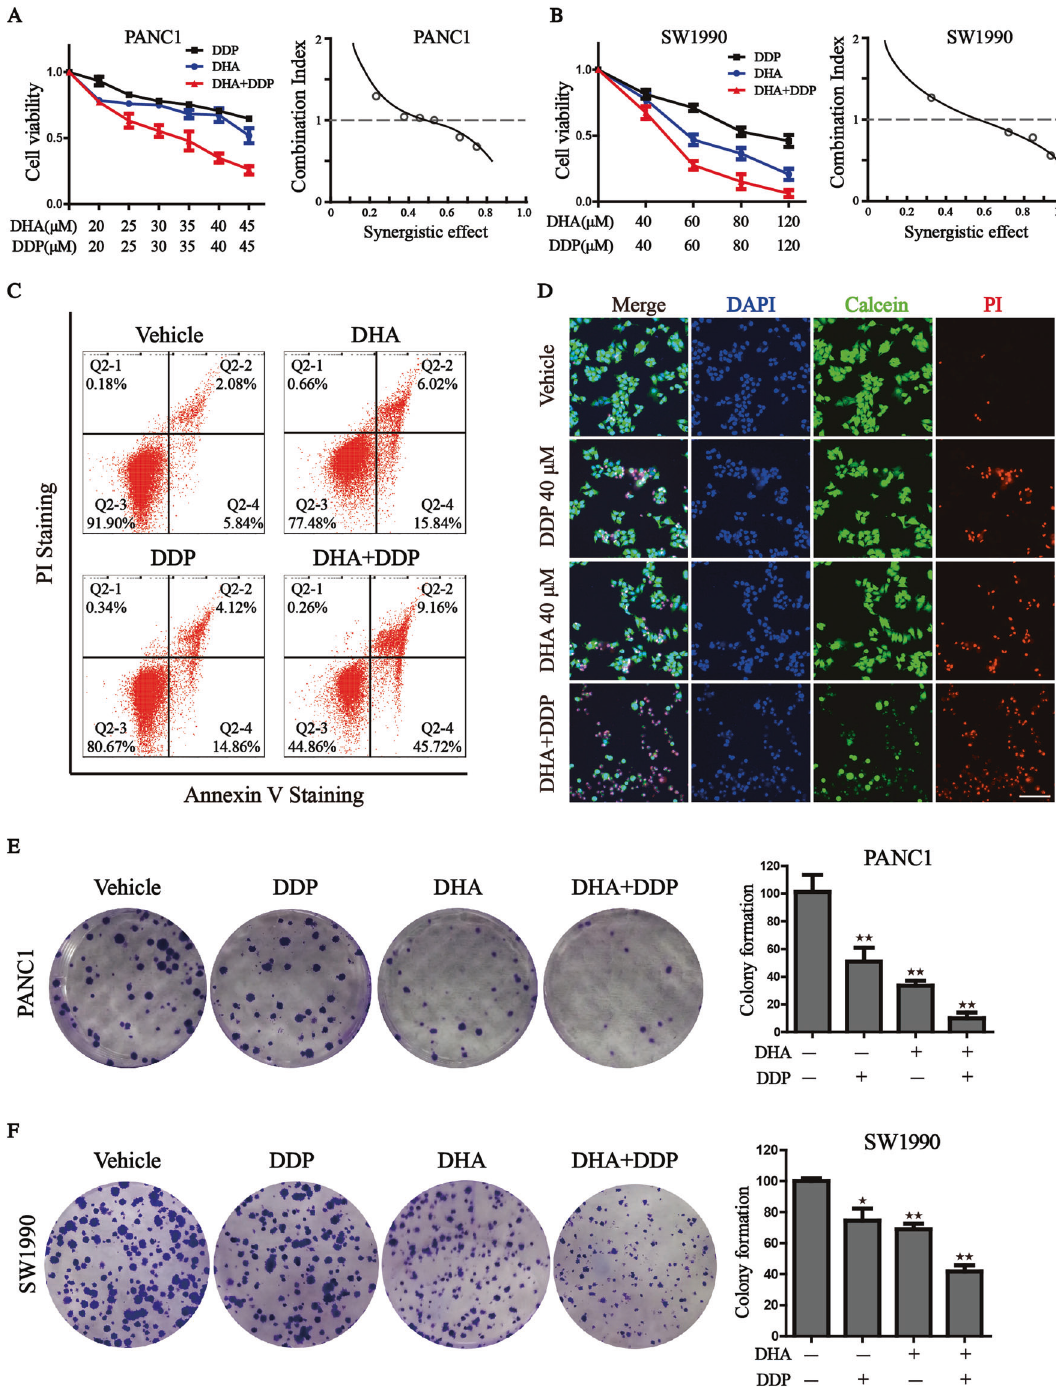
Fig. 1 Synergistic antitumor effect of DHA in combination with DDP. A , B Pancreatic cancer cells were subjected to different concentrations of DHA and DDP treatment for 24 h and cell viability was detected by CCK-8 assay. Combination index (CI) values were calculated by Compusyn software. C PANC1 cells were subjected to 40 µM DHA or/and DDP treatment for 24 h and followed by Annexin V-FITC/PI assay. D PANC1 cells were pretreated with 40 µM DHA or/and DDP for 24 h and subjected to the Calcein-AM/PI staining (Calcein AM: live cells, PI: dead cells). Scale bar: 100 µm. E , F The colony formation assay of PANC1 and SW1990 cells were performed under mono or combination treatment of DHA (5 µM for PANC1 or 10 µM for SW1990) and DDP (5 µM for PANC1 or 10 µM for SW1990) for 7 days. The representative images and the corresponding quantitative histograms from three independent experiments are shown (values represented mean ± SD. ★ P < 0.05, ★★ P < 0.01 versus control).